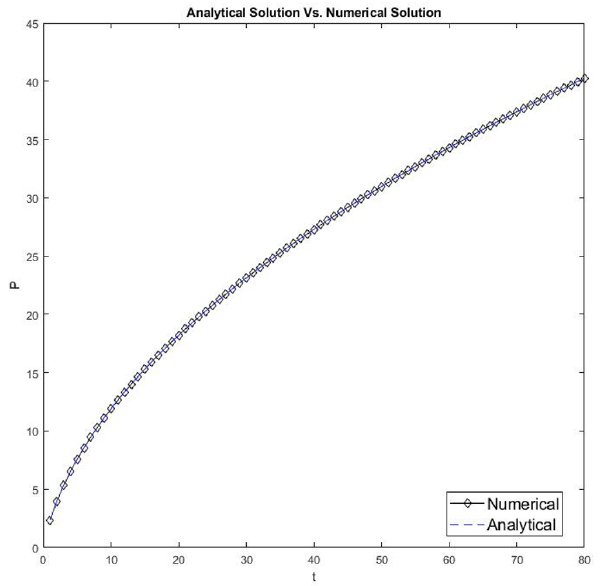
Figure A2. Analytical inversion Versus numerical inversion of Equation (A16).